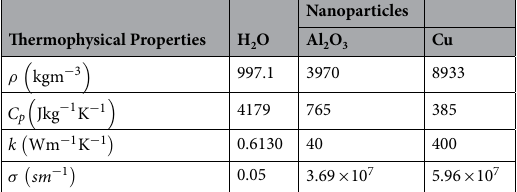
Table 3. Thermophysical properties for pure water and nanoparticles 45,46